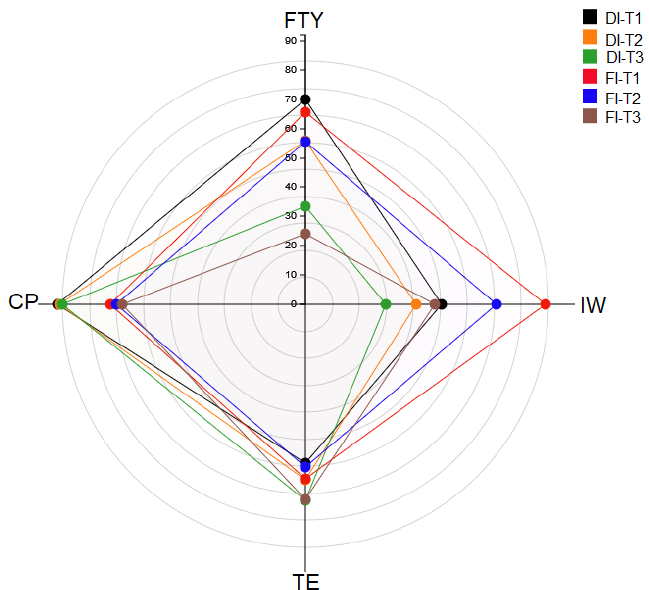
Figure 4. Radar diagram illustrating drip (DI) and furrow (FI) irrigation systems under control (T1) and thresholds of 0.4 (T2) and 0.6 (T3) of the crop water stress index (CWSI) for agronomic (FTY), environmental (TE), and economic (PC) indicators. See abbreviations in Table